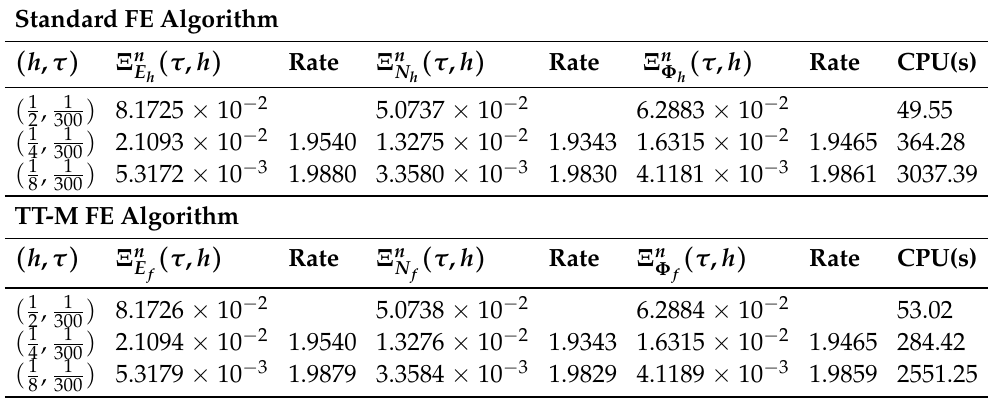
Table 5. Space convergence results for Example 2 in Case 2 with τ C = 4 τ